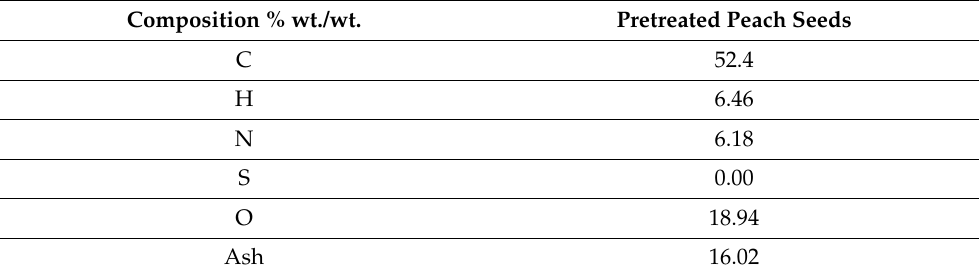
Table 2. Elemental analyses of pretreated peach seeds.